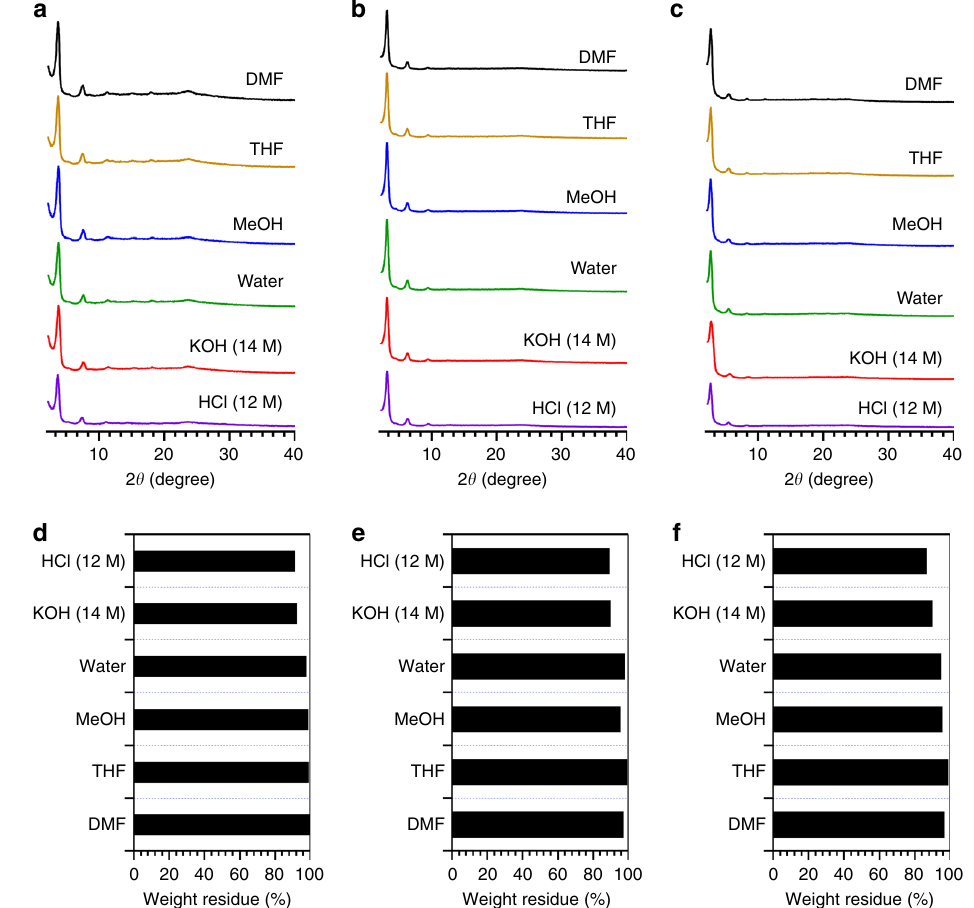
Fig. 2 Stability. a – c PXRD patterns of a sp 2 c-COF, b sp 2 c-COF-2, and c sp 2 c-COF-3 after treatment in different solvents for 1 week. d – f Residual weight percentage of d sp 2 c-COF, e sp 2 c-COF-2, and f sp 2 c-COF-3 after treatment in different solvents for 1